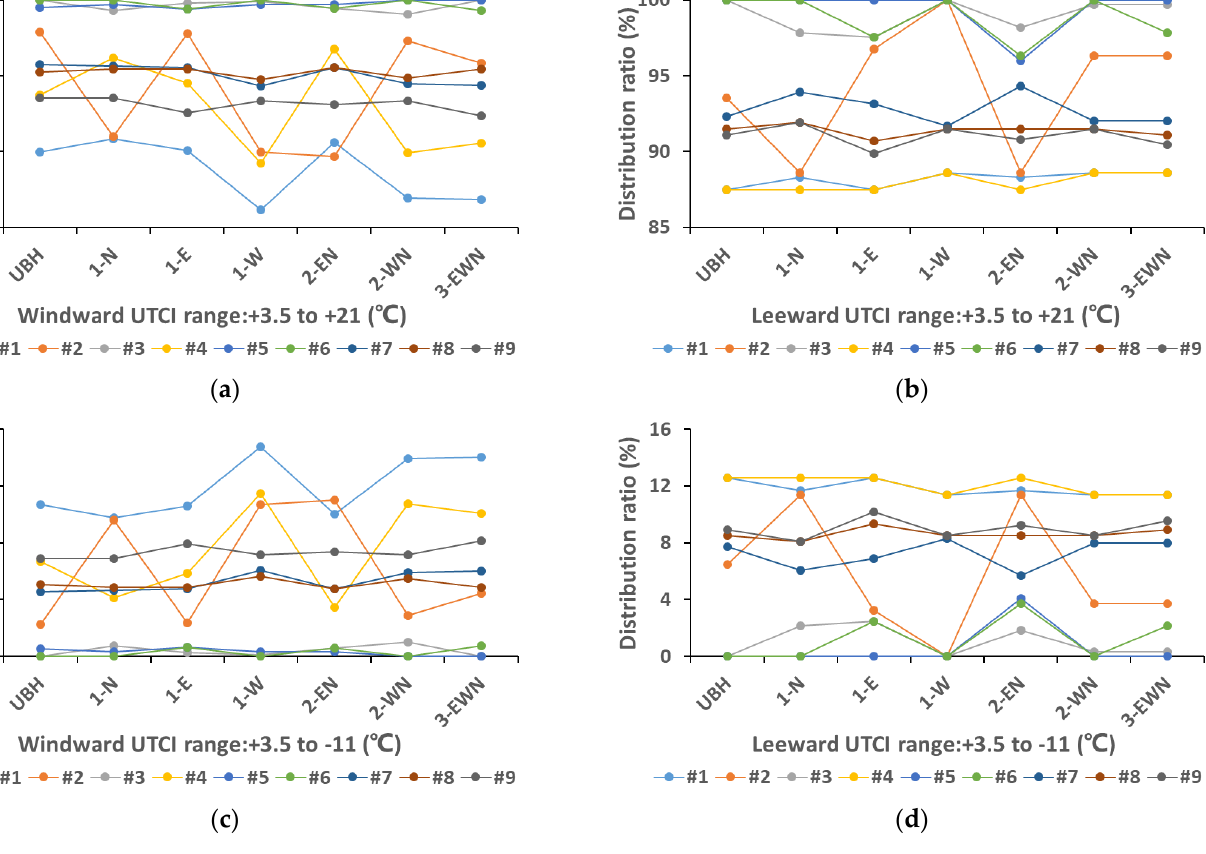
Figure 11. Proportion distribution of UTCI interval of seven building distribution patterns. ( a ) Wind-